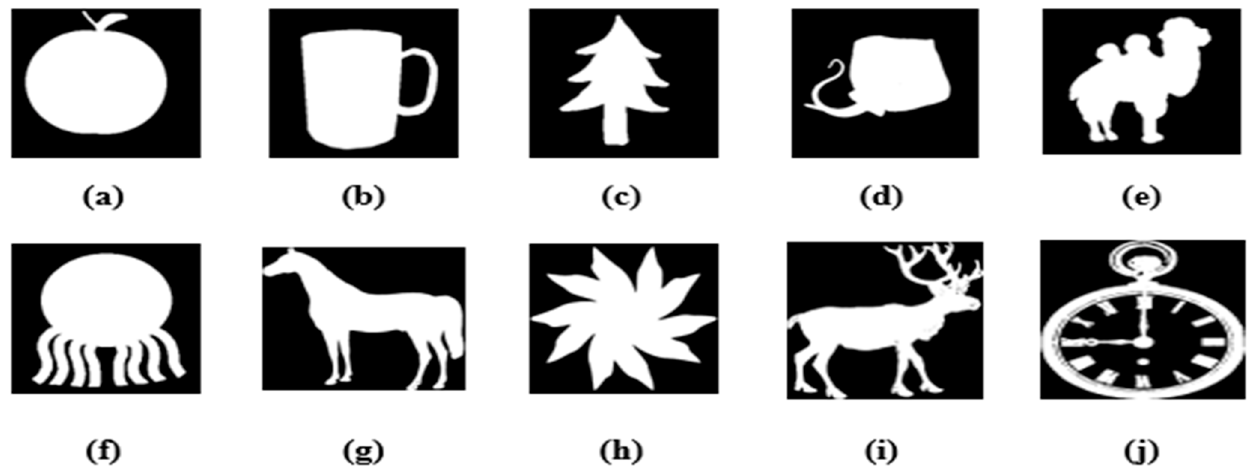
Figure 3. Original MRI color medical images.